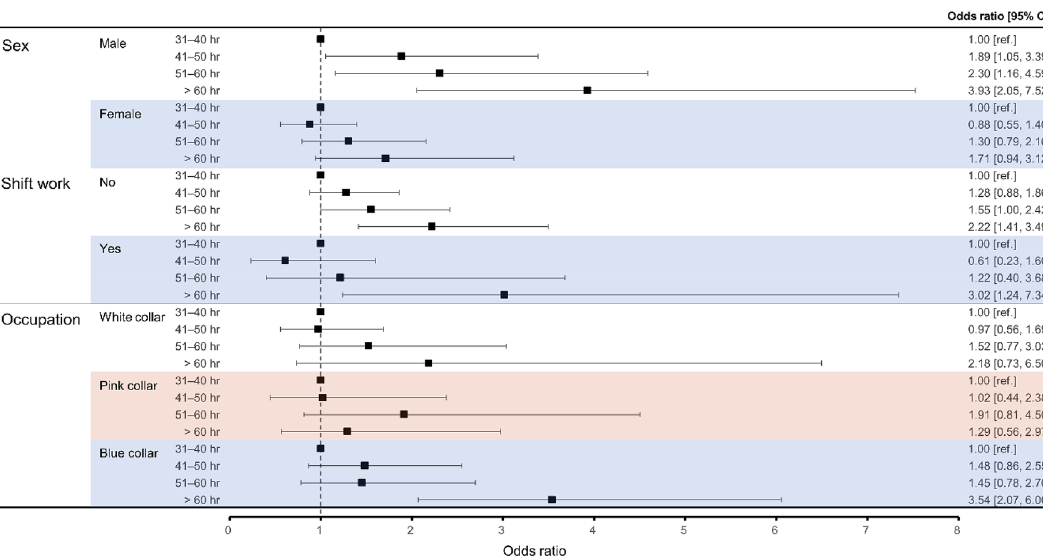
Figure 3. Associations of suicidal ideation with working hours according to subgroup. Model 3 was fully adjusted for age, sex, smoking status, alcohol consumption, educational level, household income, marital status, perceived health status, occupation, sleep duration, physical activity, and comorbidities. CI, confidence